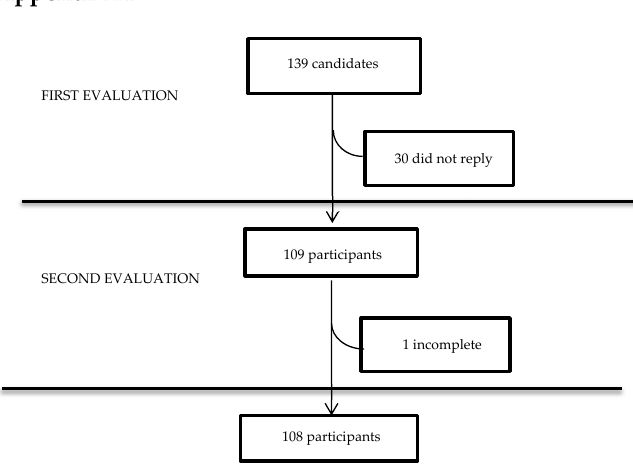
Figure A1. Flaw chart of participants included in the study.